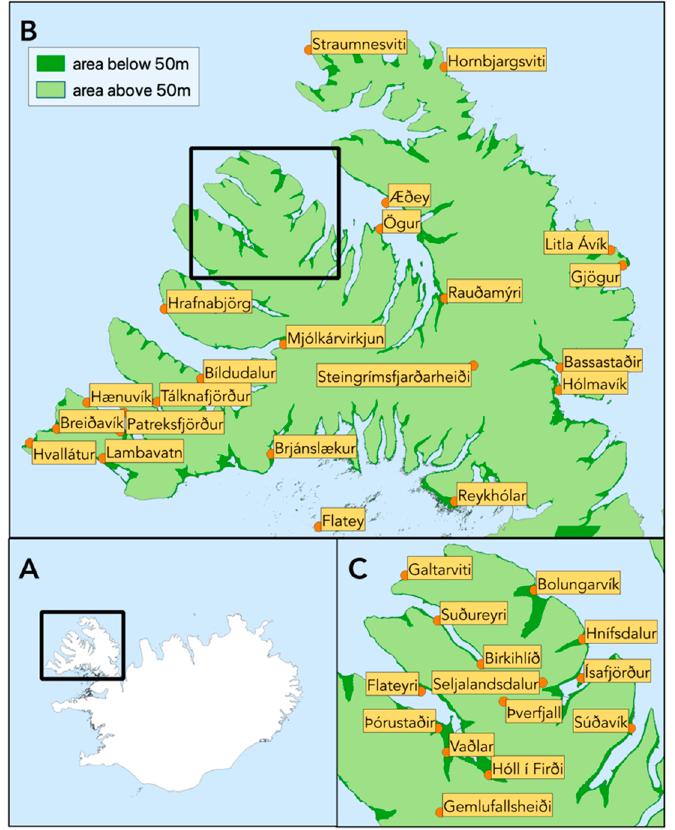
Figure 2. Locations and names of weather stations used in this study. ( A = the location of the Westfjords region within Iceland, B & C = distribution of weather stations in relation to elevation, C = dense network of stations around the most populous region of the Westfjords.)